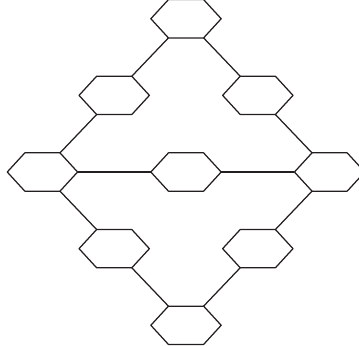
Figure 2: Unit (1, 1) of hydrocarbon